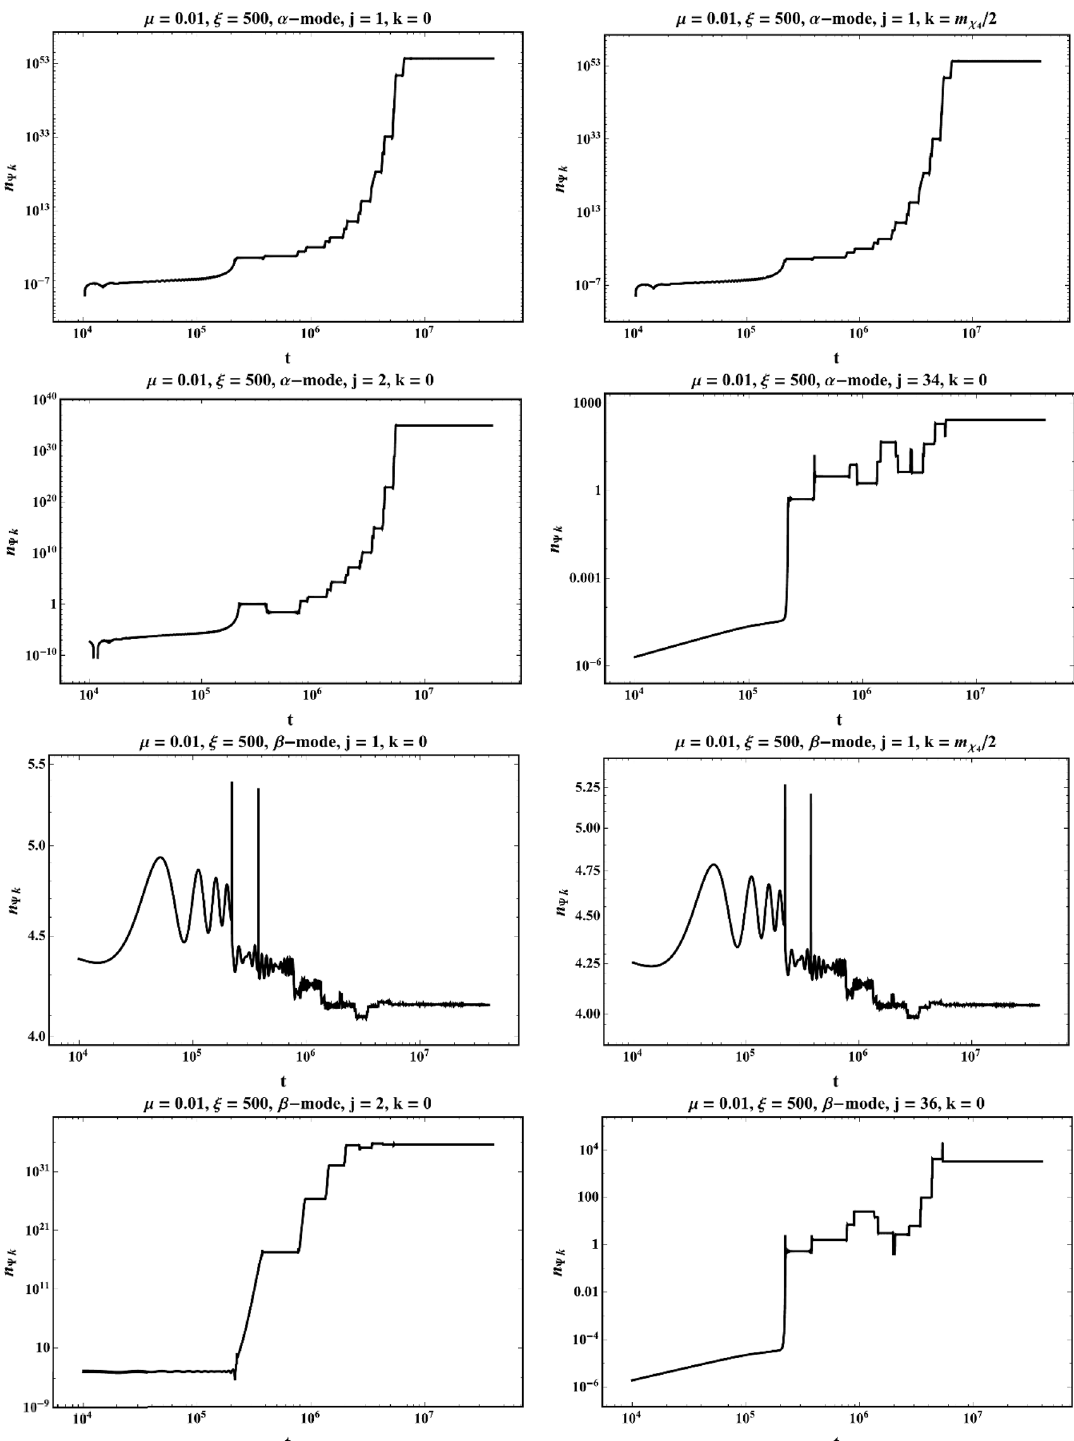
Figure 5 . The time evolution of the logarithm of the number density of the various scalar preheat (cid:12)elds, (cid:9) i , vs. logarithm of time, for (cid:22) = 0 : 01 and (cid:24) = 500.